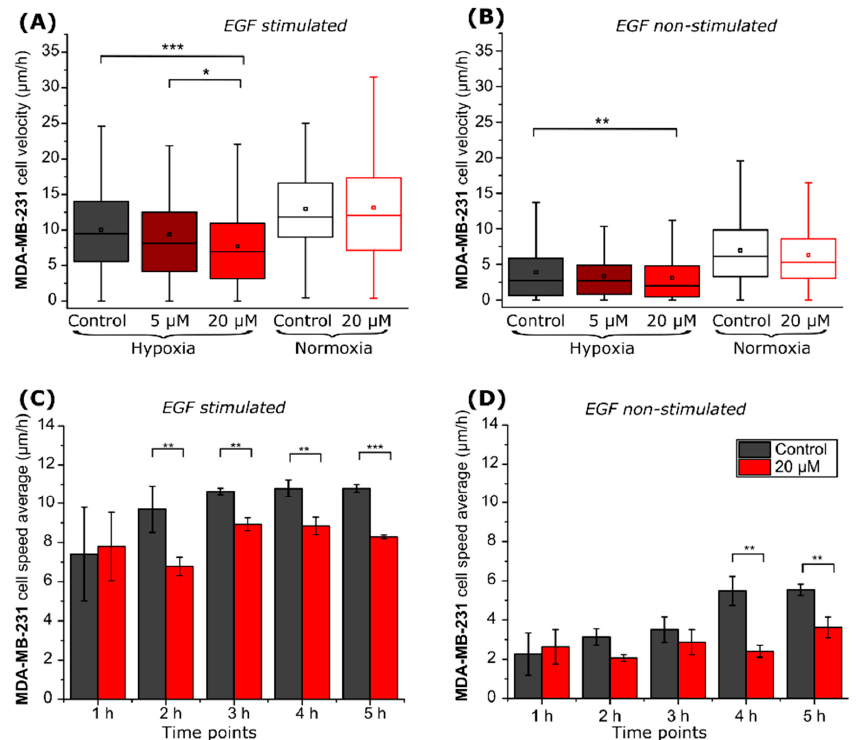
Figure 4. MDA-MB-231 cell migration properties. Control and VD11-4-2 (5, 20 µM) treated MDA- MB-231 cell velocities ( A , B ) and hypoxic cell speed changes during the time ( C , D ), then cells are stimulated ( A , C ) and non-stimulated with EGF ( B , D ) (* p < 0.05; ** p < 0.01; *** p < 0.001). Afterward, experiments with another breast cancer cell line MCF-7 were conducted.